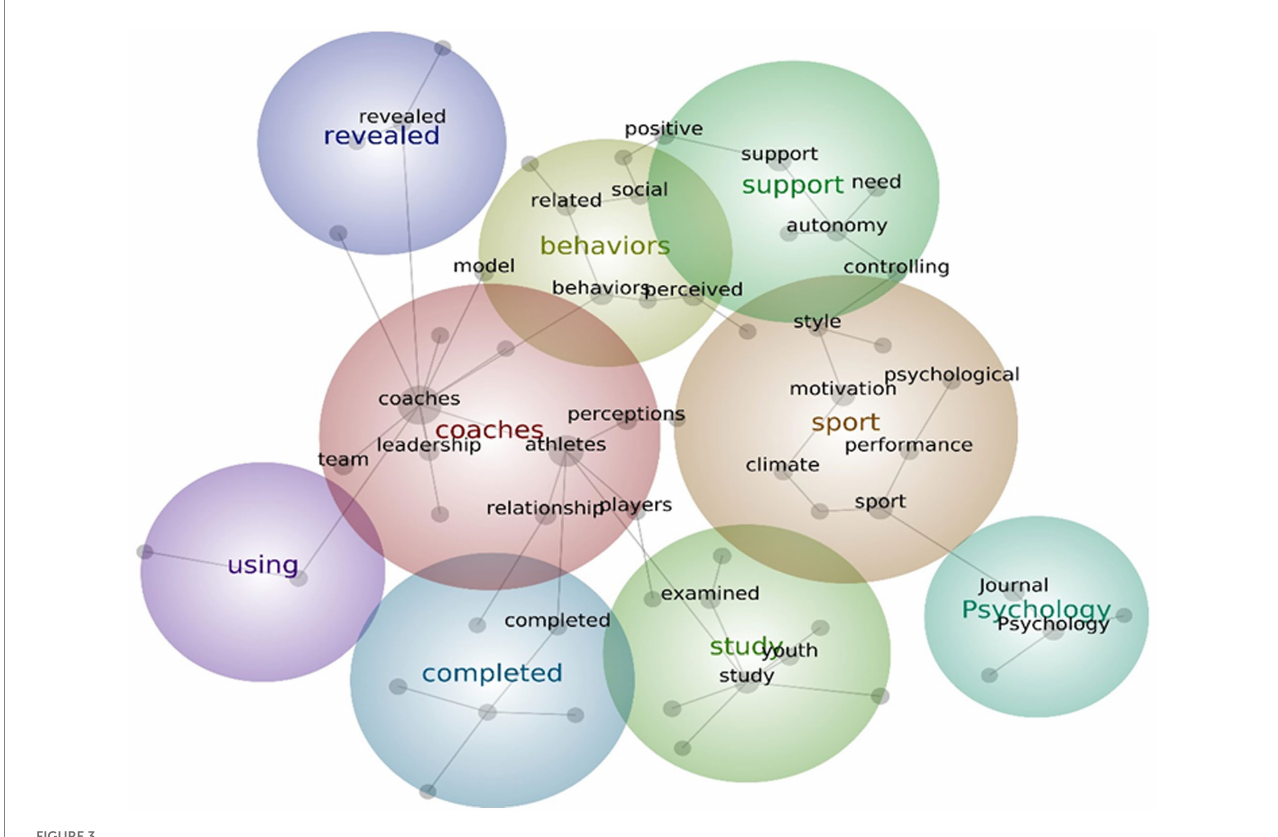
FIGURE 3 Overall concept map of coach leadership